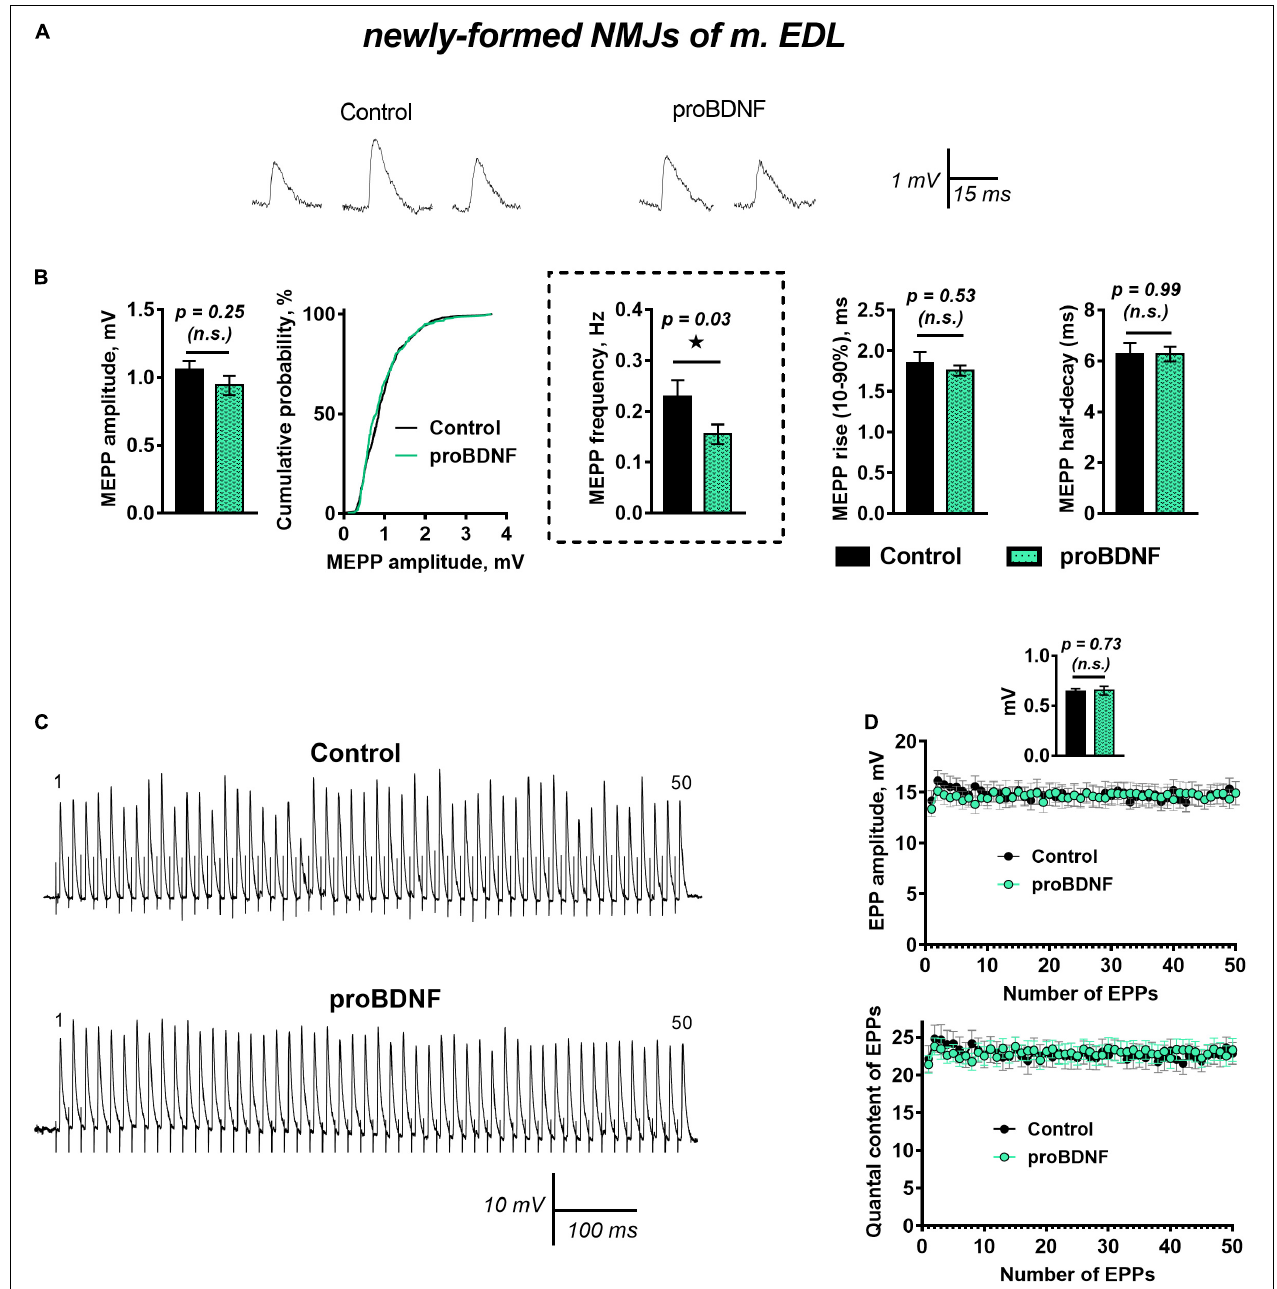
FIGURE 1 | proBDNF in low concentration (1 nM) decreases the rate of spontaneous ACh release at newly formed NMJs but has no effect on evoked ACh release at newly formed NMJs. (A) Representative recordings of MEPPs in control (left) and upon application of proBDNF (right). (B) Mean MEPP amplitude, cumulative probability plots, frequency and time-course parameters (left to right) in control ( n = 27) and upon application of proBDNF ( n = 30). (C) Representative recordings of EPPs during a short (1 s) high-frequency (50 Hz) train in control (above) and upon application of proBDNF (below). (D) Changes in the EPP amplitude (above) and in the quantal content of EPPs (below) in control ( n = 19) and in the presence of proBDNF ( n = 24). Inset shows MEPP